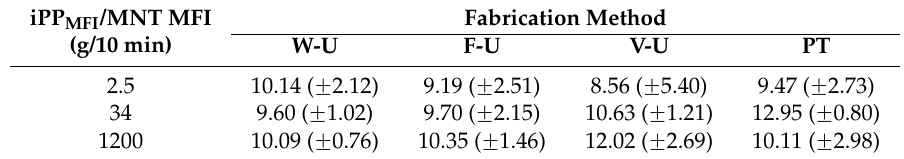
Table 2. Agglomerate size ( µ m) for iPP/MNT nanocomposites fabricated by different methods.